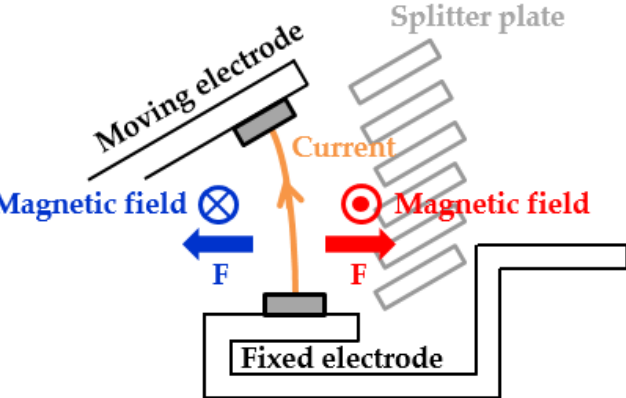
Figure 2. Magnetic field effects on circuit breaker.